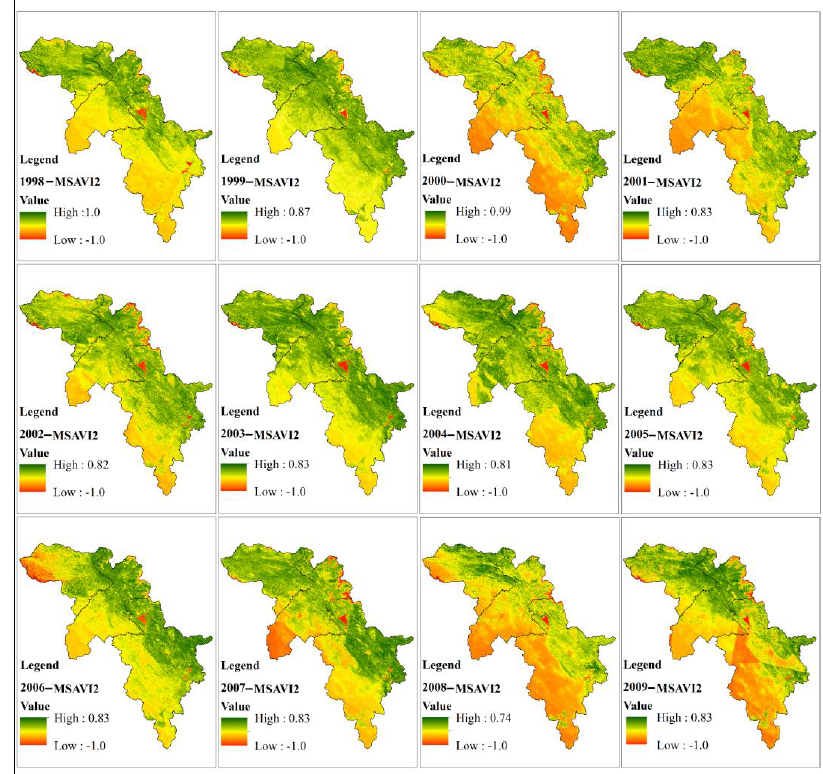
Figure 3. Spatial variation of the MSAVI2 − based vegetation from 1998 to 2009.